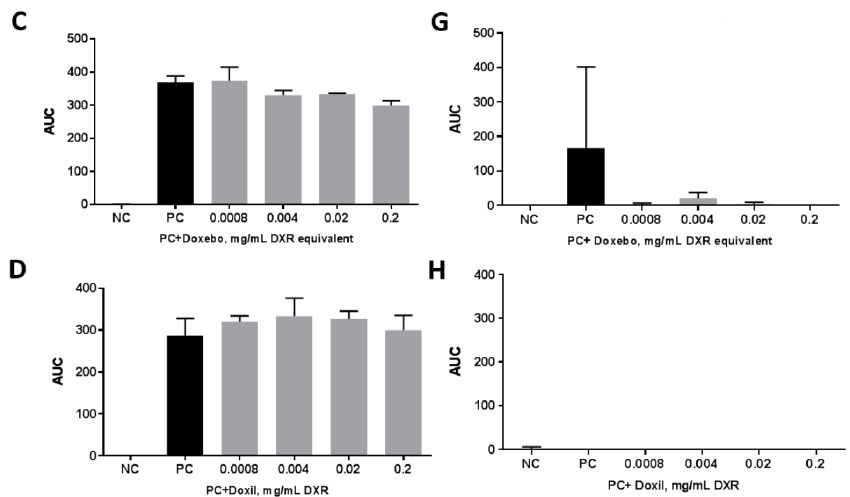
Figure 3. Platelet aggregation assay. Various clinically relevant concentrations of Doxil and Doxebo were spiked into platelet reach plasma (PRP), and platelet aggregation was monitored in real time during six minutes of sample incubation at 37 °C ( A , B , E , F ). Particle effects on collagen-induced platelet aggregation were tested by adding the collagen into PRP spiked with test nanomaterials ( C , D , G , H ). The AUC of nanoparticle-treated plasma ( A , B , E , F ) were compared to the negative control sample (NC). The AUC of the collagen-treated plasma pre-incubated with nanoparticles ( C , D , G , H ) was compared to the AUC of the PC. PC was collagen. NC was PBS. Plasma anticoagulated with Na-citrate ( A – D ) was compared to plasma anticoagulated with hirudin ( E – H ). Blood from the same donor volunteers was used for all tests. Doxebo and Doxil samples were conducted on different days due to the low throughput of the light transmission aggregometry. Shown is mean ± SD ( n = 3).